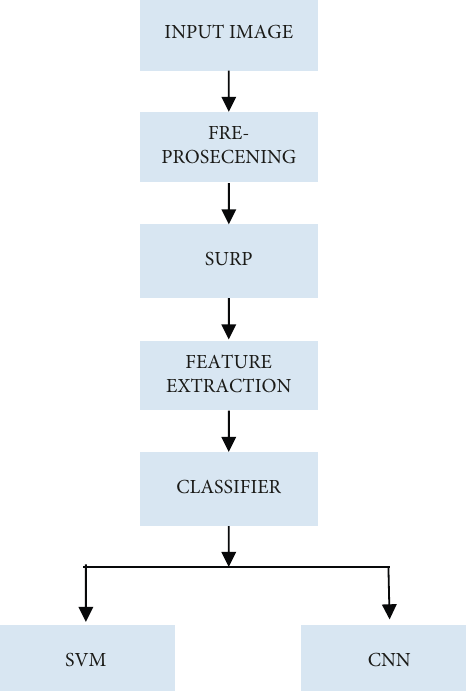
Figure 3: Experiment flow chart by Chauhan